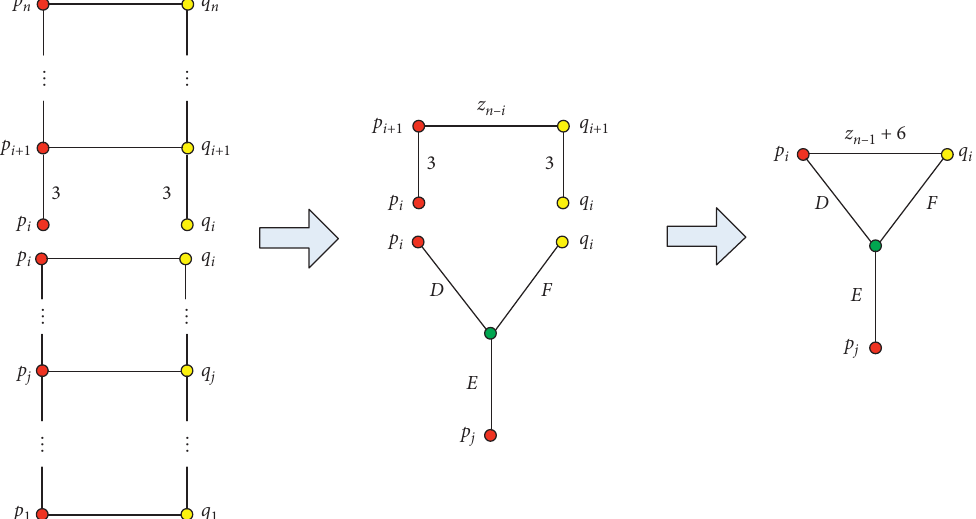
p ,p q n i + 1 , and i + 1